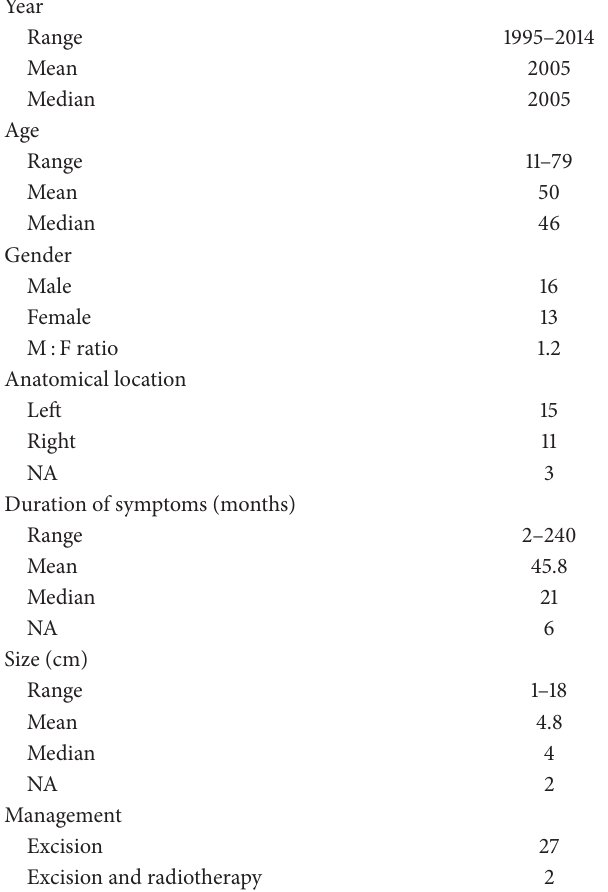
Table 1: Summary of all cases of parotid SFT in the current literature.